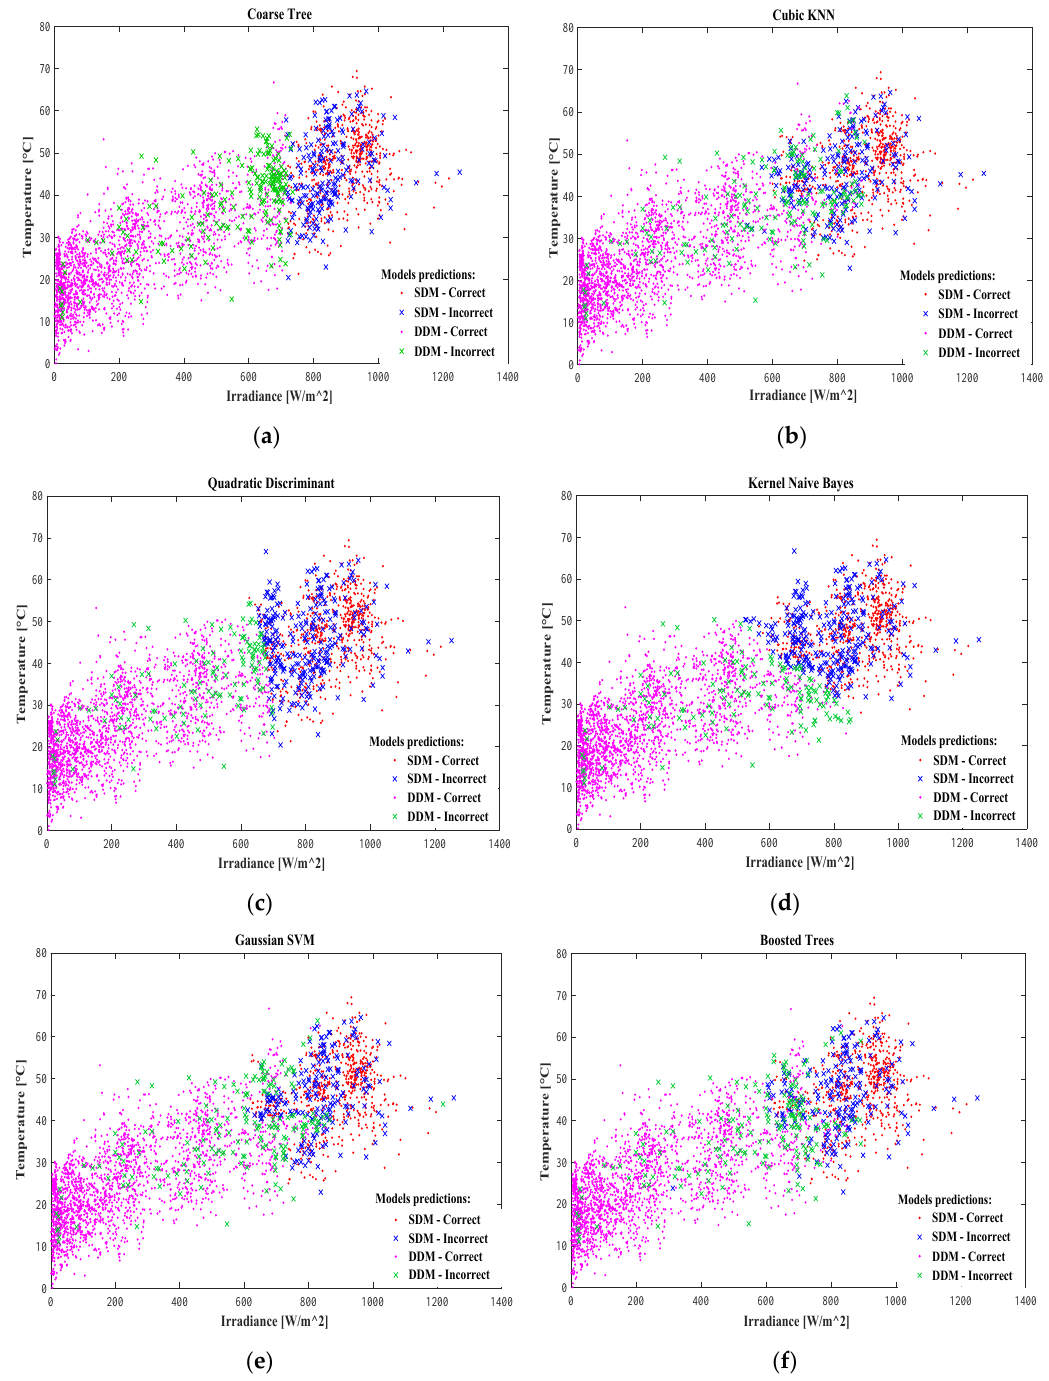
Figure 10. Predicted powers using SDM and DDM under a variation of solar irradiance and temperature. ( a ) Coarse Tree; ( b ) Cubic KNN; ( c ) Quadratic Discriminant; ( d ) Kernel Naïve Bayes; ( e ) Gaussian SVM; ( f ) Boosted trees.